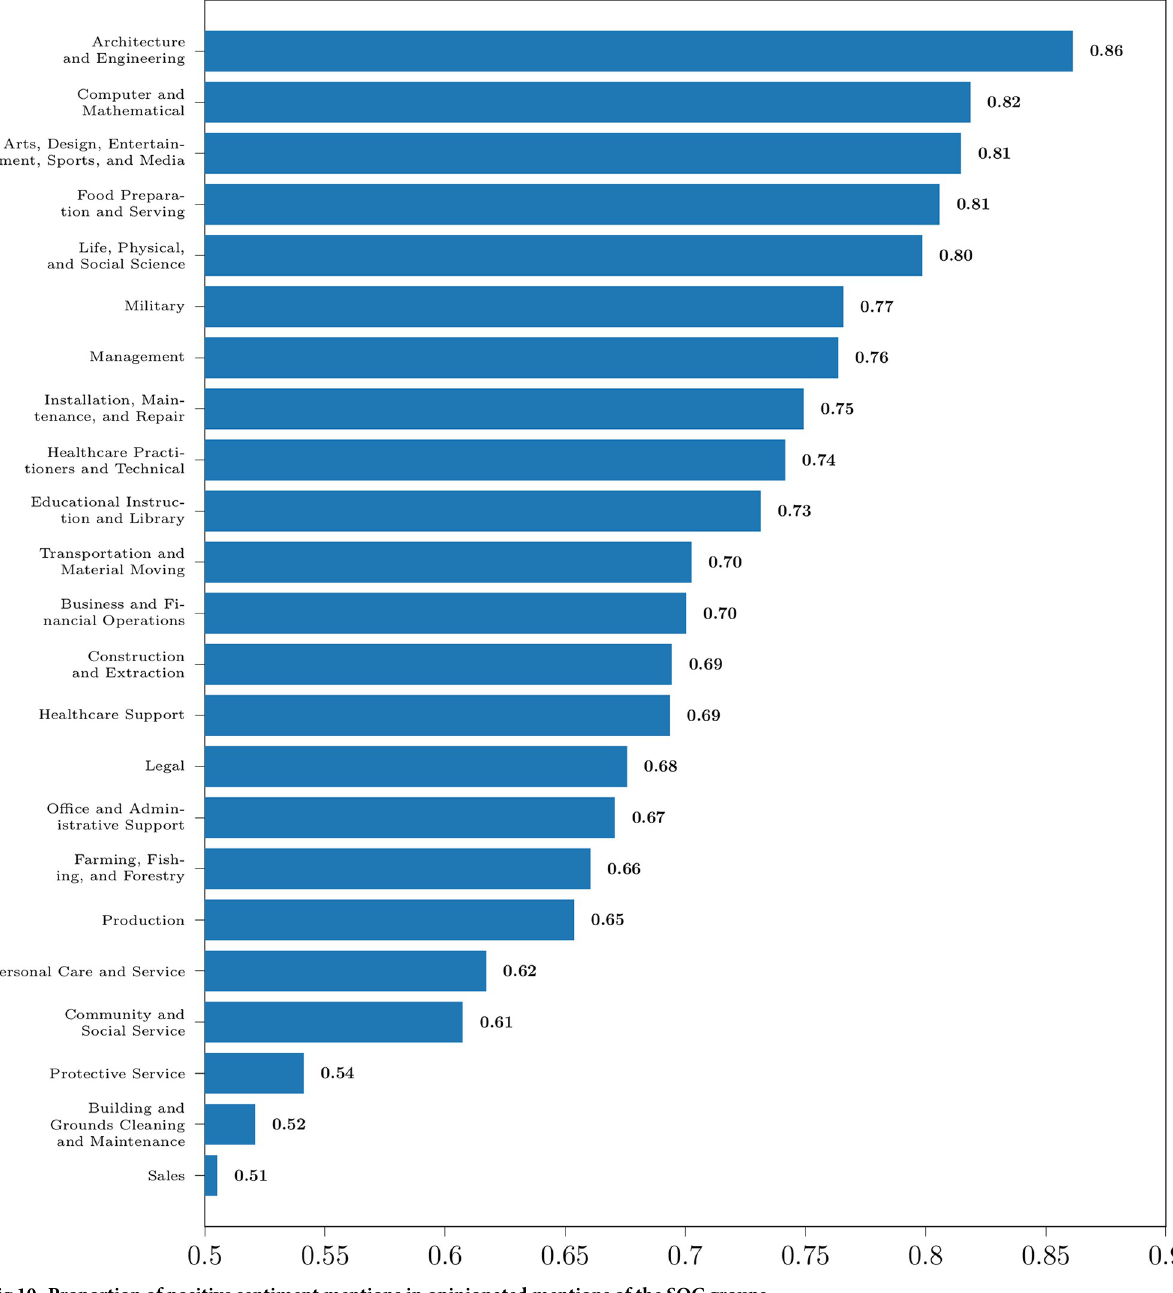
Fig 10. Proportion of positive sentiment mentions in opinionated mentions of the SOC groups. Fig 10 shows the proportion of positive sentiment mentions of the 23 major SOC groups. From the figure, we observe that the proportion is always greater than 0.5. Therefore, the num- ber of positive sentiment mentions is greater than the number of negative sentiment mentions for all the SOC groups. This might be because of an inherent positive bias in the sentiment of media narratives. Architects and engineers are talked about most positively, and sales-related